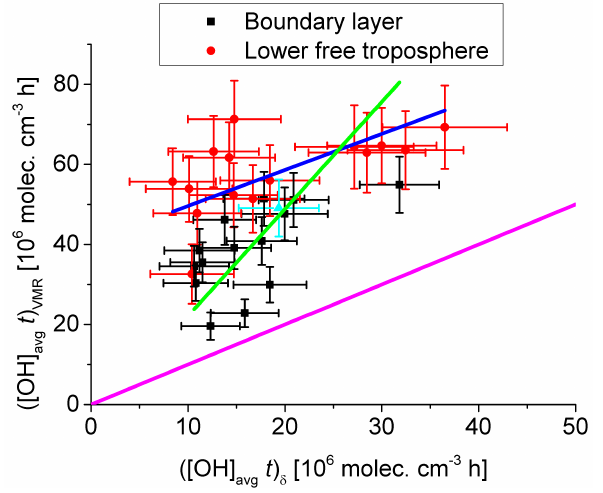
Fig. 17. Comparison of photochemical ages: ([ OH ] avg t ) VMR (derived from toluene/benzene ratios) versus ([ OH ] avg t ) δ (derived from toluene δ 13 C values); the source values were estimated rather roughly (see text) and their uncertainties are not included in the error bars. Two linear fits are applied (green: to PBL data, slope 2 . 55 ± 0 . 58 ; blue: to free troposphere data, slope 0 . 91 ± 0 . 29 ; one data point, shown in light blue, from the LFT has a rather PBL-like isotope ratio/mixing ratio characteristic, see Fig. 16, and was therefore excluded from the fit). A line y = x (purple) is shown for comparison.